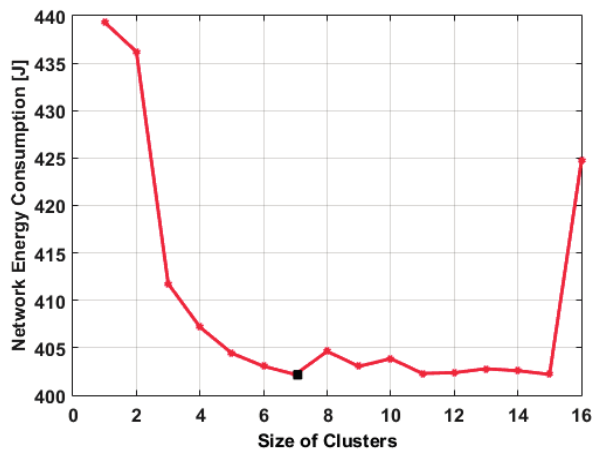
Figure 7. Energy consumption for clusters